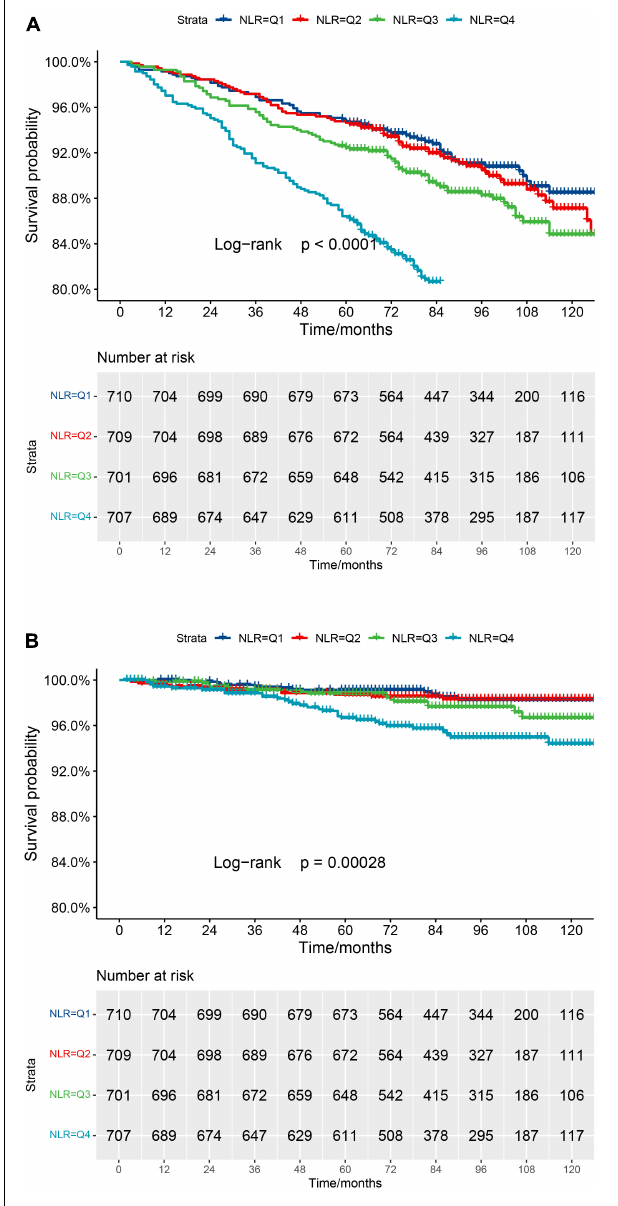
FIGURE 2 | (A) Kaplan–Meier survival curve for all-cause mortality. (B) Kaplan–Meier survival curve for cardiovascular mortality.